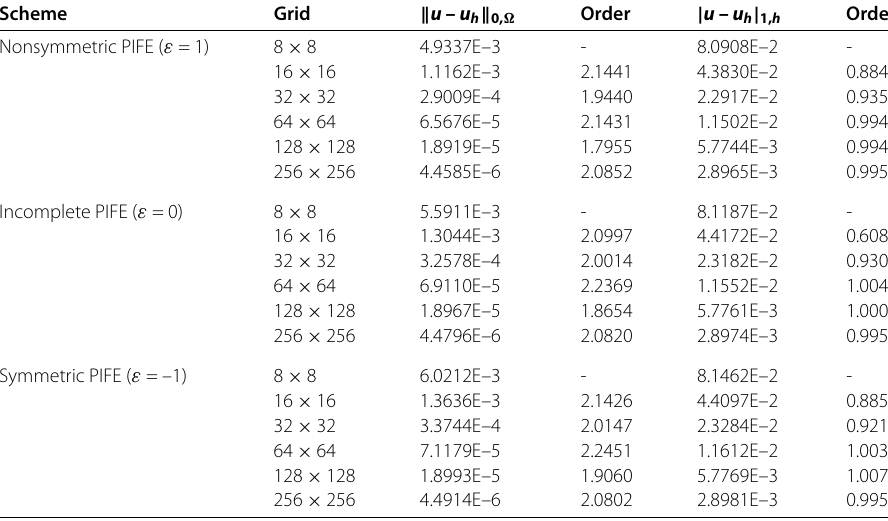
Table 1 Numerical results for ( β – , β + ) = (1,1,000) with different PIFE schemes Scheme